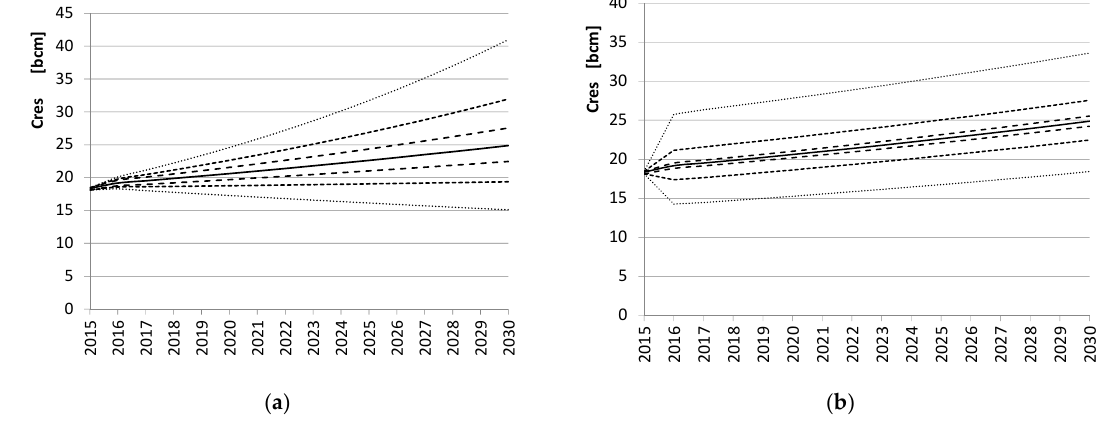
Figure 2. Forecasted values of natural gas consumption, C res , and associated 95% confidence bounds. ( a ) Linear increase of the std. dev. associated to the exogenous variables, three different rates starting from 1.5% up to 10%, 25% and 50% at the end of the time horizon; ( b ) Constant std. dev. during the whole time horizon, three different levels; 1.5%, 10% and 30%.